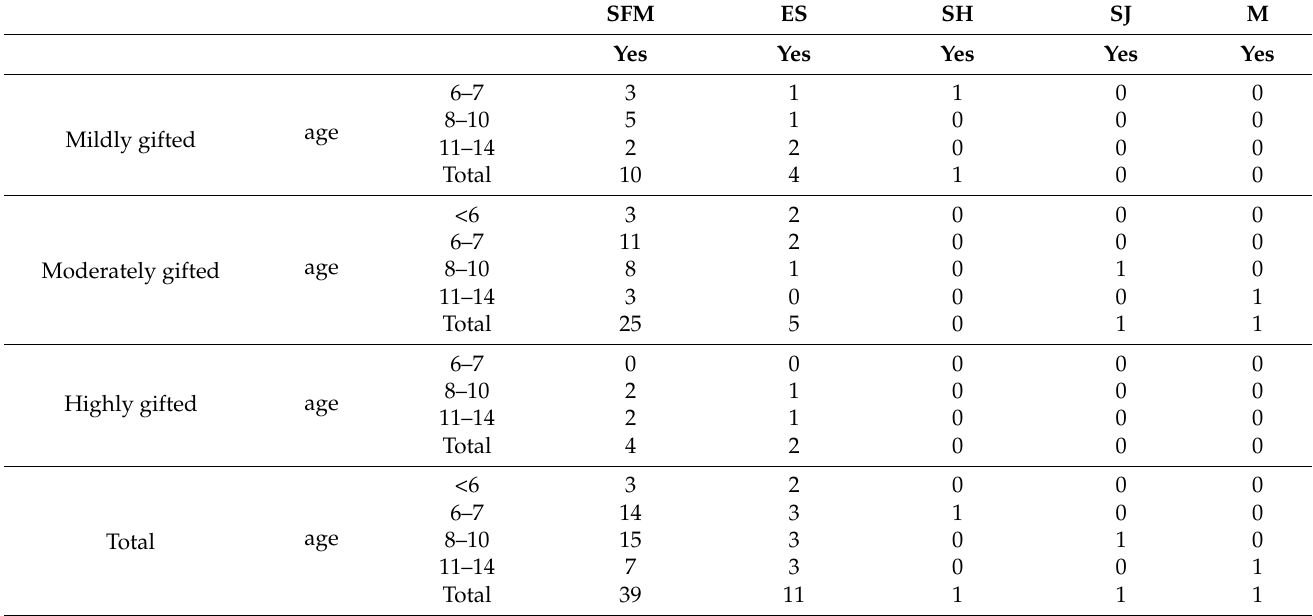
Table 6. Children’s socio-emotional